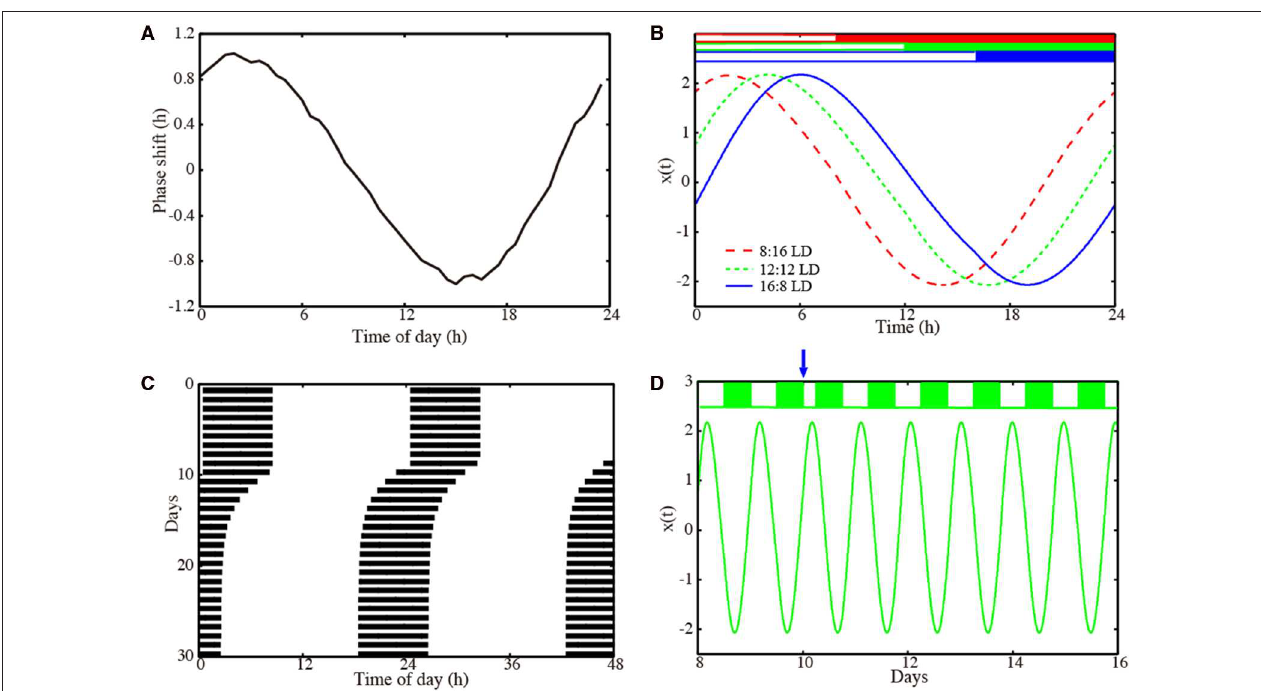
FIGURE 2 | Properties of our amplitude-phase model for a representative optimized parameter set. (A) Phase response curve with respect to a 6 h light pulse. (B) Waveforms x ( t ) of the oscillator entrained to Zeitgeber signals with 8:16 LD (dashed red line), 12:12 LD (dotted green line), and 16:8 LD (solid blue line). (C) Actogram of the oscillator, to which a 6 h advancing jet lag was induced on day 10. (D) Time-trace x ( t ) of the oscillators, to which a 6 h advancing jet lag was induced on day 10. Model parameters: τ = 23.36 h, A = 2.063, λ = 0.386 h − 1 with ω = 2 π τ